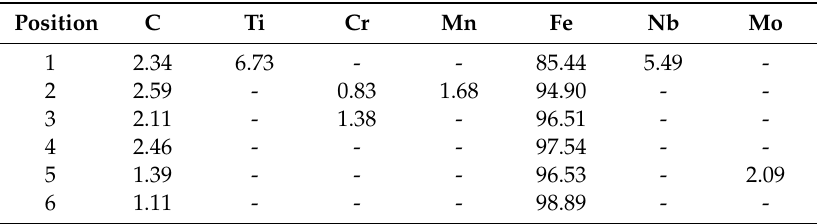
Table 2. EDS analysis of tube banded area in Figure 9b (mass fraction/%).